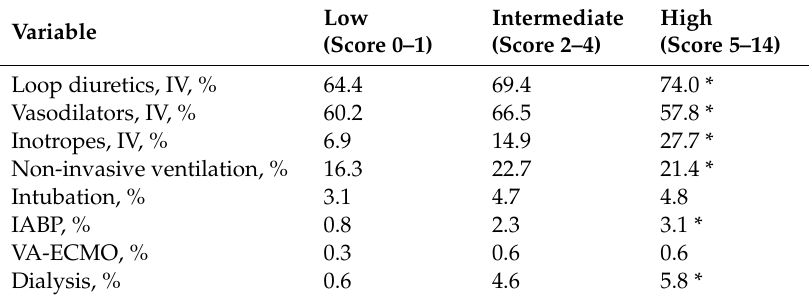
Table 5. In-hospital treatment according to estimated risks by the integer